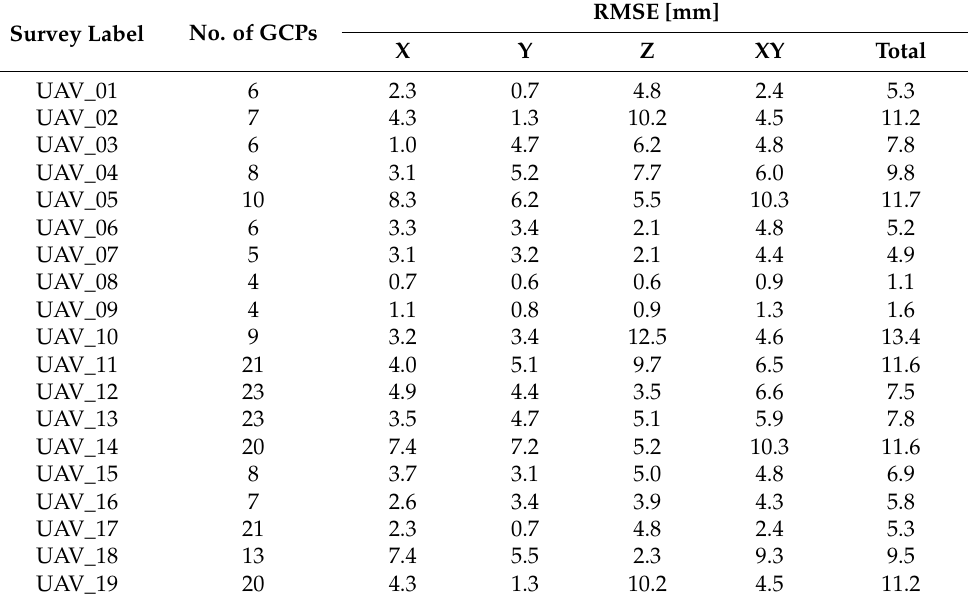
Table 3. RMSE of point clouds on GCPs—results from Agisoft Metashape. Survey